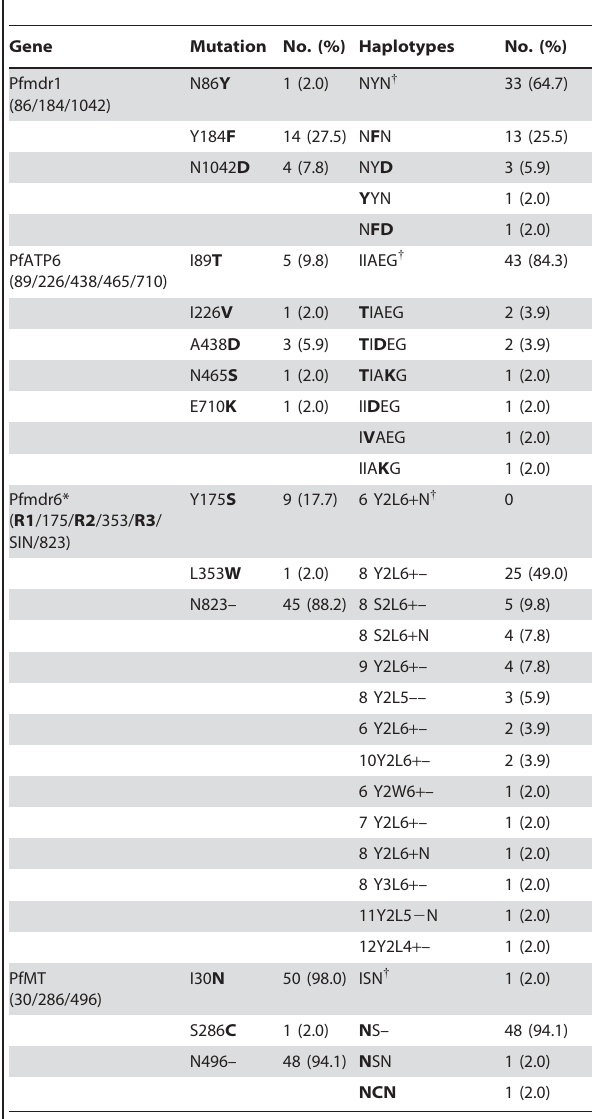
Table 3. Amino acid substitutions and resulting haplotypes in four studied genes from 51 parasite